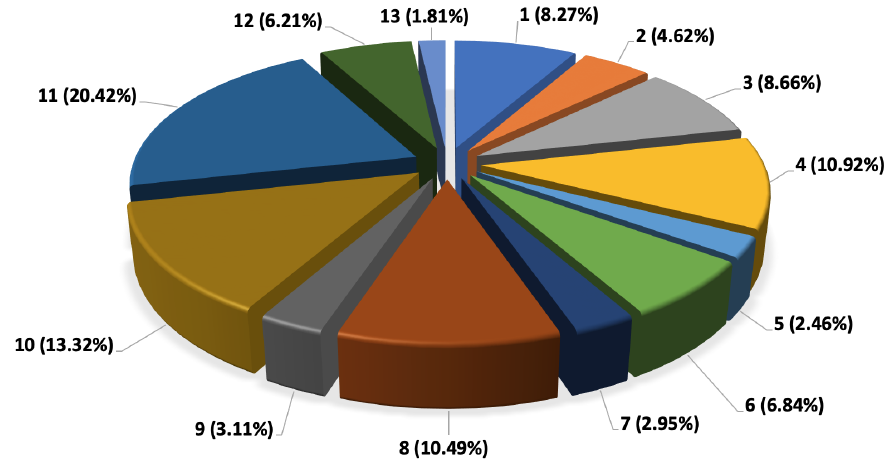
Figure 13. CO 2 emission percentage per delivery.